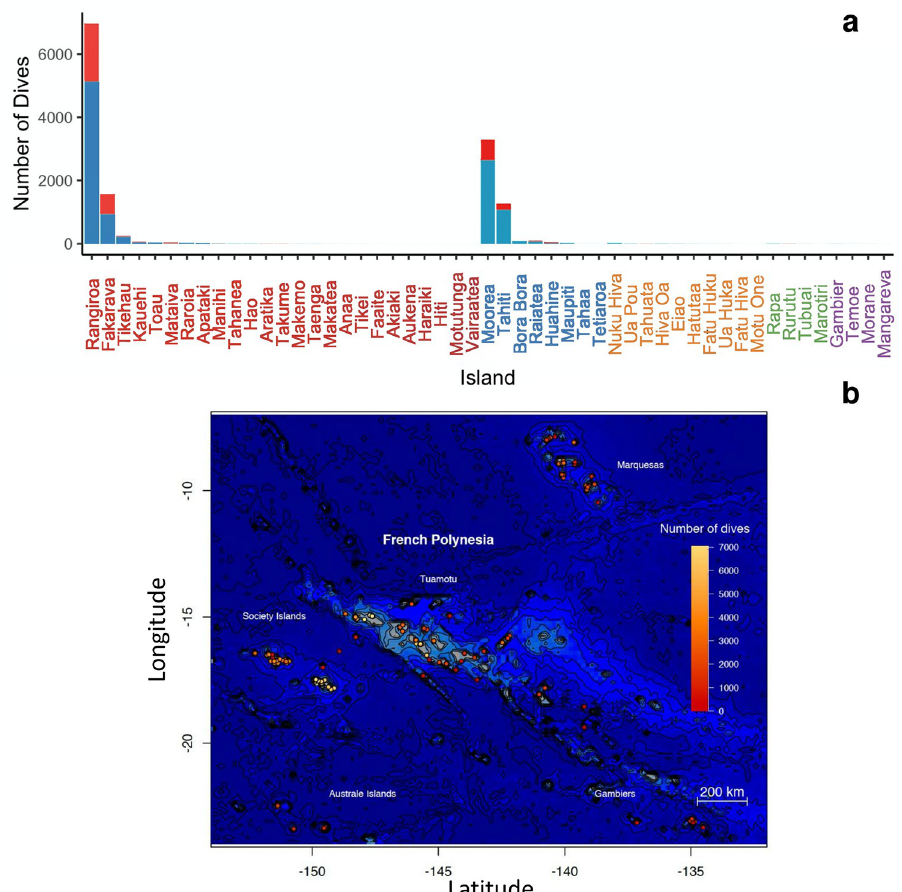
Fig 2. (a) Total number of dives reported according to the islands sampled. The blue part of the histogram corresponds to the number of dives where at least one individual of a species considered as “rare" is observed. The red part corresponds to the number of dives where only individuals of "common" species were counted. The archipelago to which the islands belong is represented by different colors along the x-axis: (1) red for the Tuamotu archipelago; (2) blue for the Society archipelago; (3) orange for the Marquesas archipelago; (4) green for the Australs archipelago; (5) purple for the Gambier archipelago. The islands are classified by decreasing number of dives within their archipelago. (b) Geographical distribution of the sampling